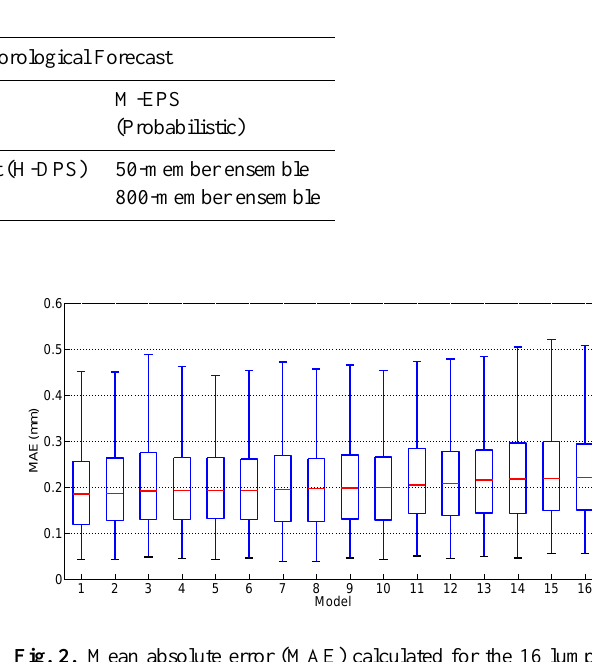
Table 3. Scenarios of hydrological ensemble predictions (H-EPS) tested in this study, based on 16 hydrological models, and deterministic (M-DPS) and probabilistic (M-EPS) rainfall forecasts.